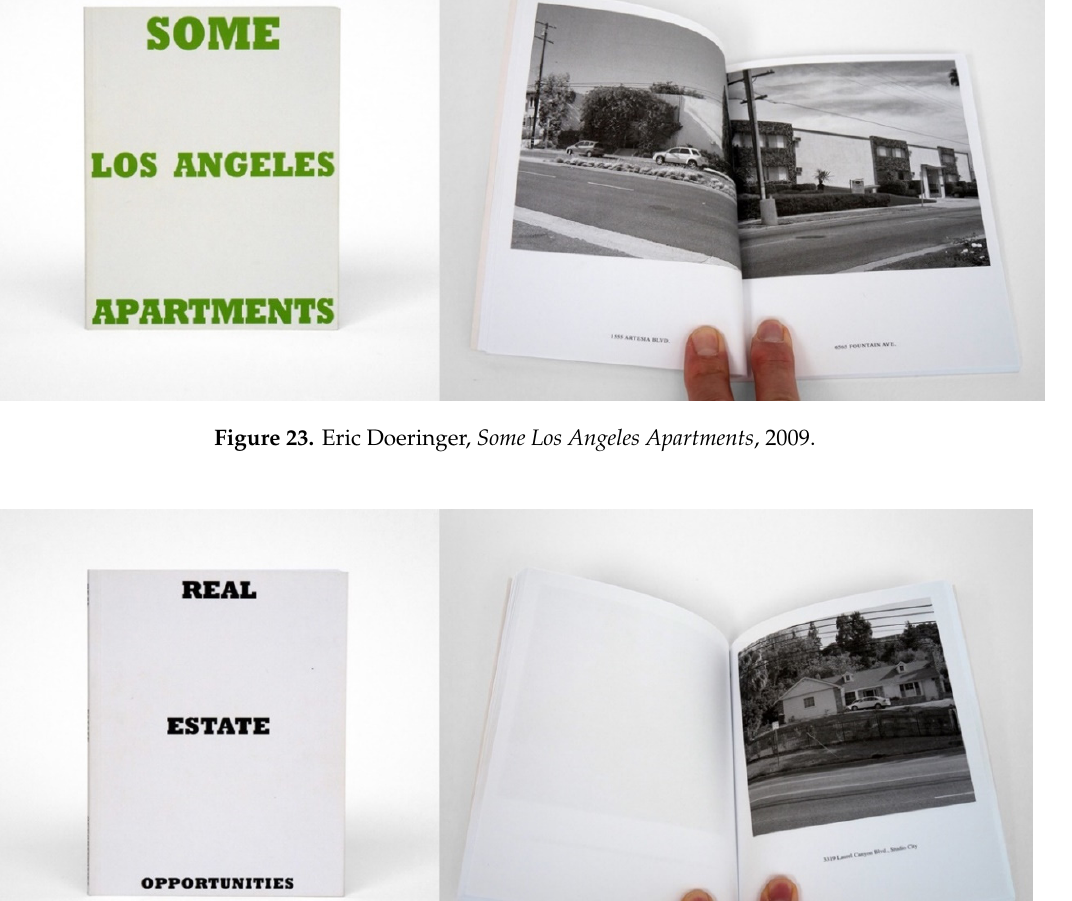
Figure 25. Eric Doeringer, Records , 2011.